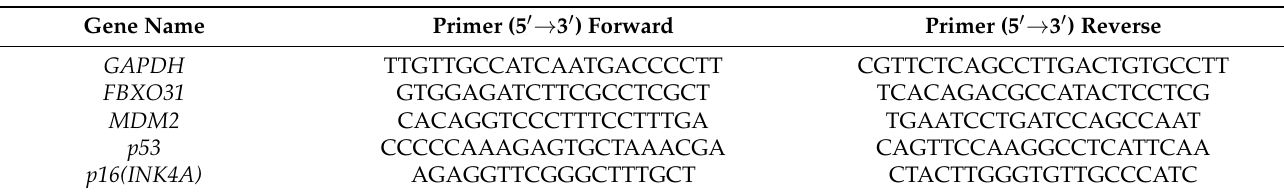
Table 1. Real-time PCR primers of target genes.